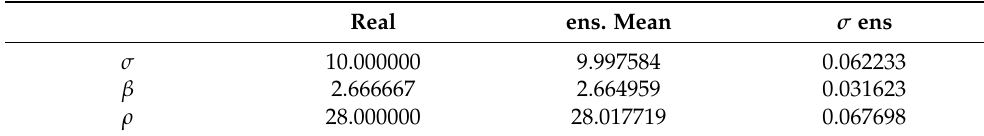
Table 2. Estimated parameters obtained using the pruned-enriching algorithm with δ variable. In the last column, we also show the standard deviation on the ensemble members. Simulation data as in Figure